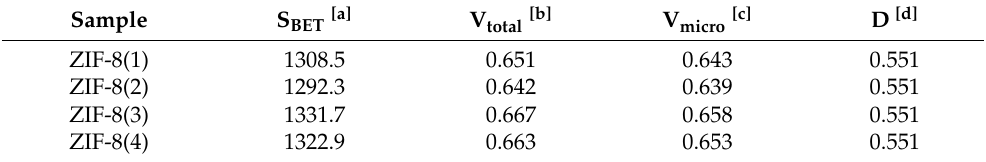
Table 1. Textural parameters of (a) ZIF-8(1), (b) ZIF-8(2), (c) ZIF-8(3), and (d) ZIF-8(4).